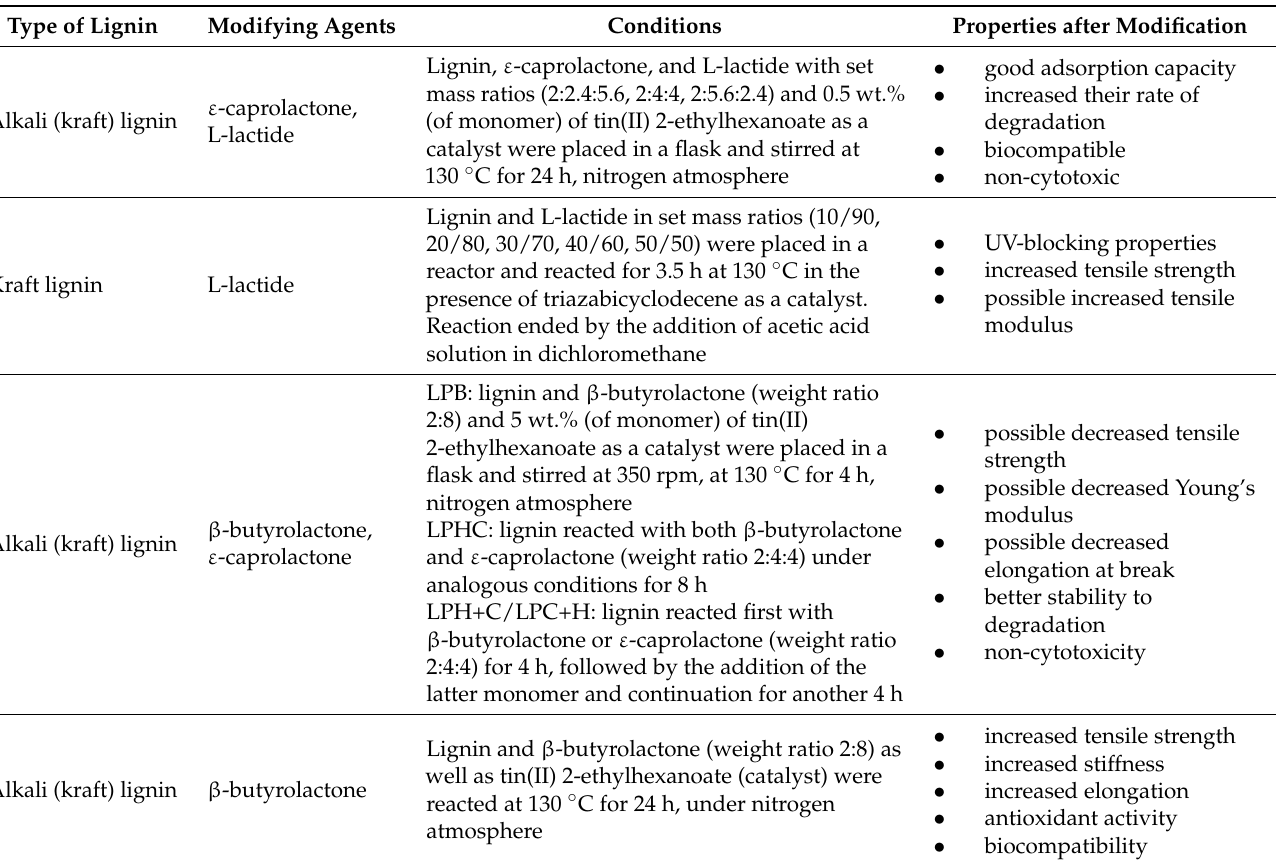
Table 9. Table summarizing copolymerization reactions of